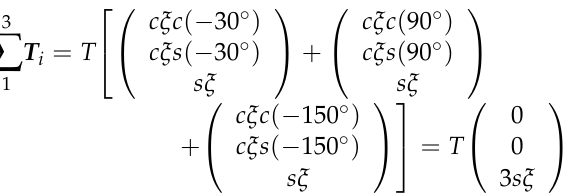
Figure 5. Top horizontal view of the wind turbine and the angles of the catenaries.